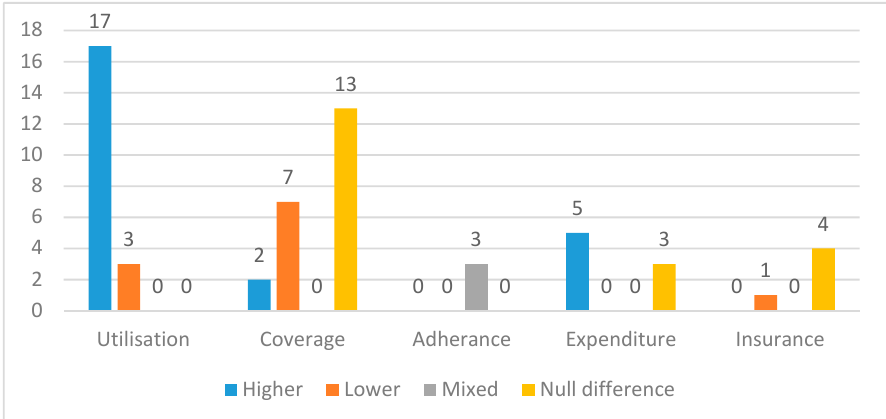
Figure 2. Results by outcome type.